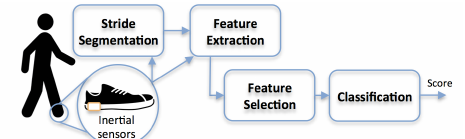
Figure 1. Block diagram of the classification pipeline.